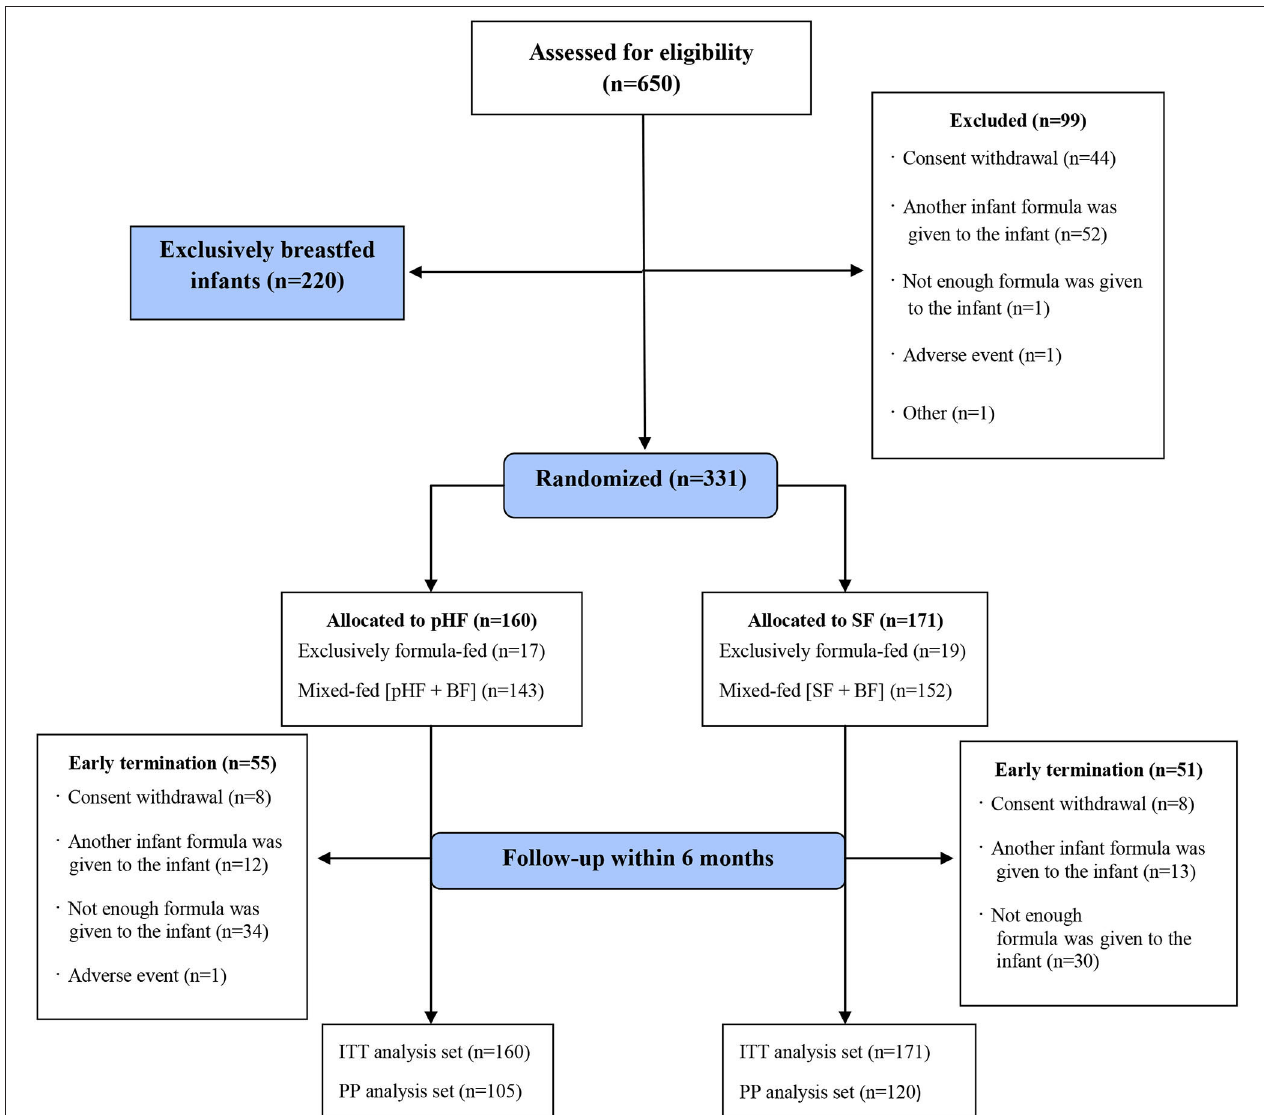
FIGURE 1 | Flow diagram of A.R.T. study population. SF, standard formula; pHF, partially hydrolyzed formula; BF, breastfeeding; ITT, intention-to-treat analysis set; PP, per-protocol analysis set.